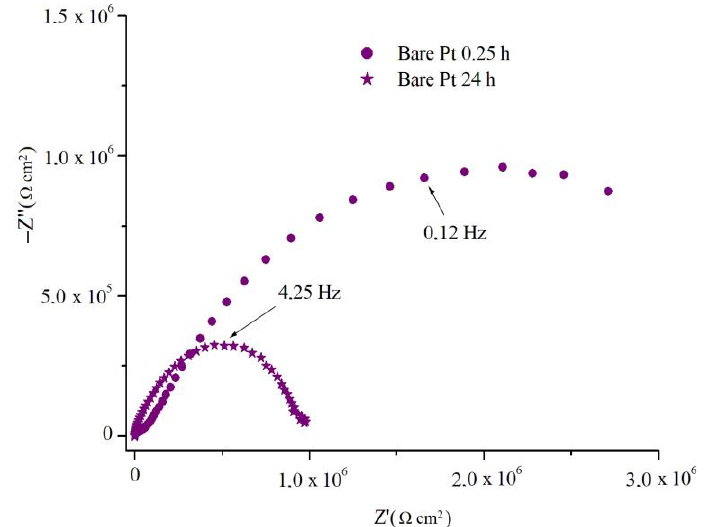
Figure 10. EIS in representation of Nyquist for uncoated Pt, after ( a ) 0.25 h and ( b ) 24 h of immersion in aqueous solution of 2 mol L −1 of H 2 SO 4 .